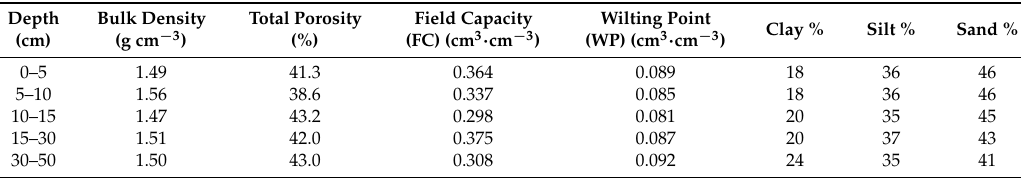
Table 1. Soil physical characteristics of the experimental field.